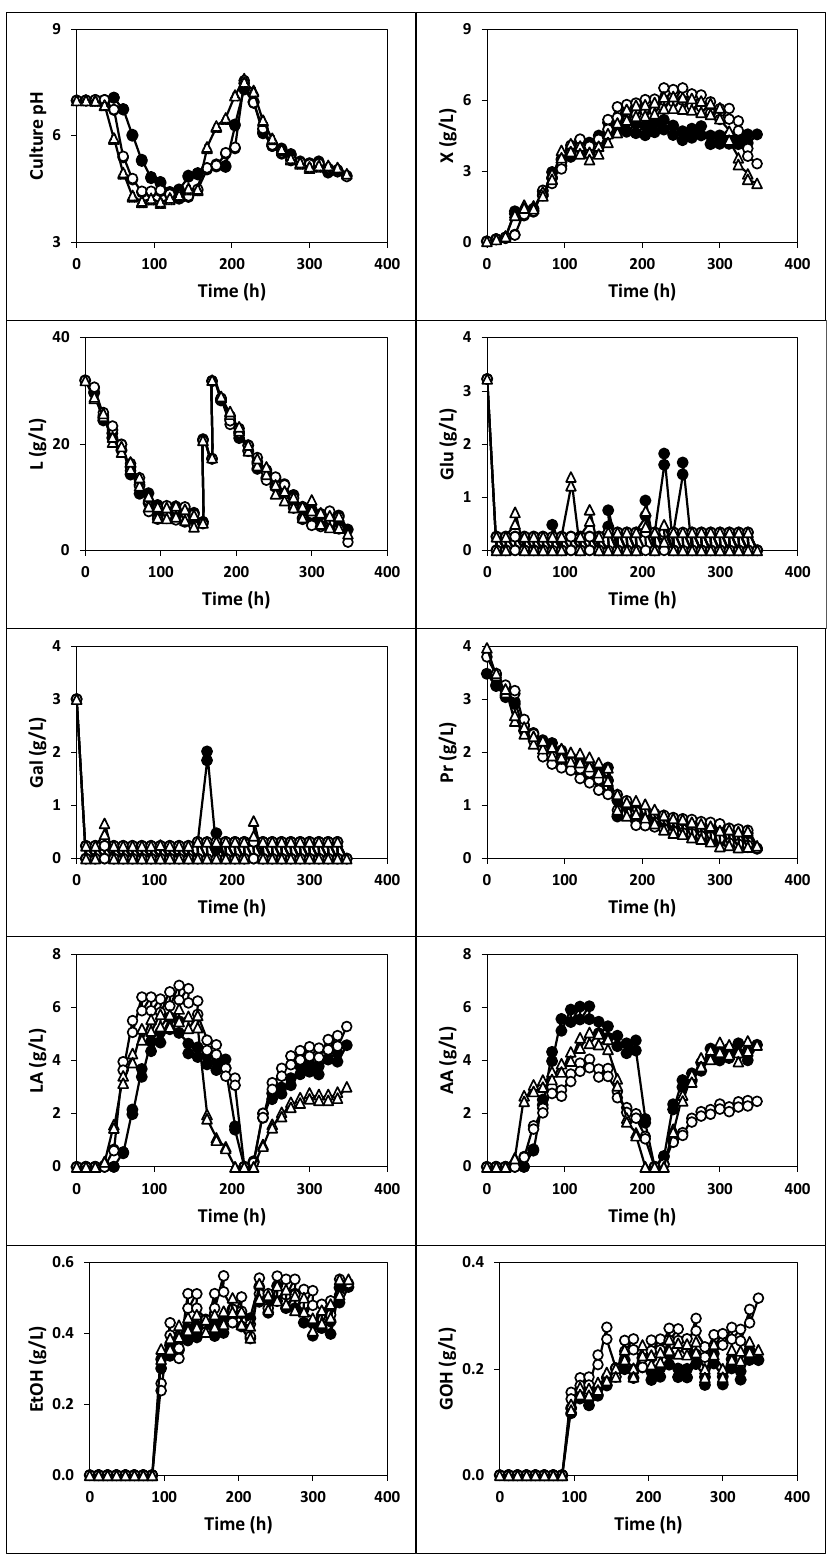
Figure 3. Fermentation kinetics (200 rpm) of whey with total free biomass from whole ( black circles ), semi-skim ( white circles ) and skim ( triangles ) milk previously fermented with kefir grains AGK1 without stirring. X: biomass, L: lactose, Glu: glucose, Gal: galactose, LA: lactic acid, AA: acetic acid, Pr: proteins, EtOH: ethanol, GOH: glycerol. The experimental data represent the means of two cultures carried out in parallel with two analytical replicates each.